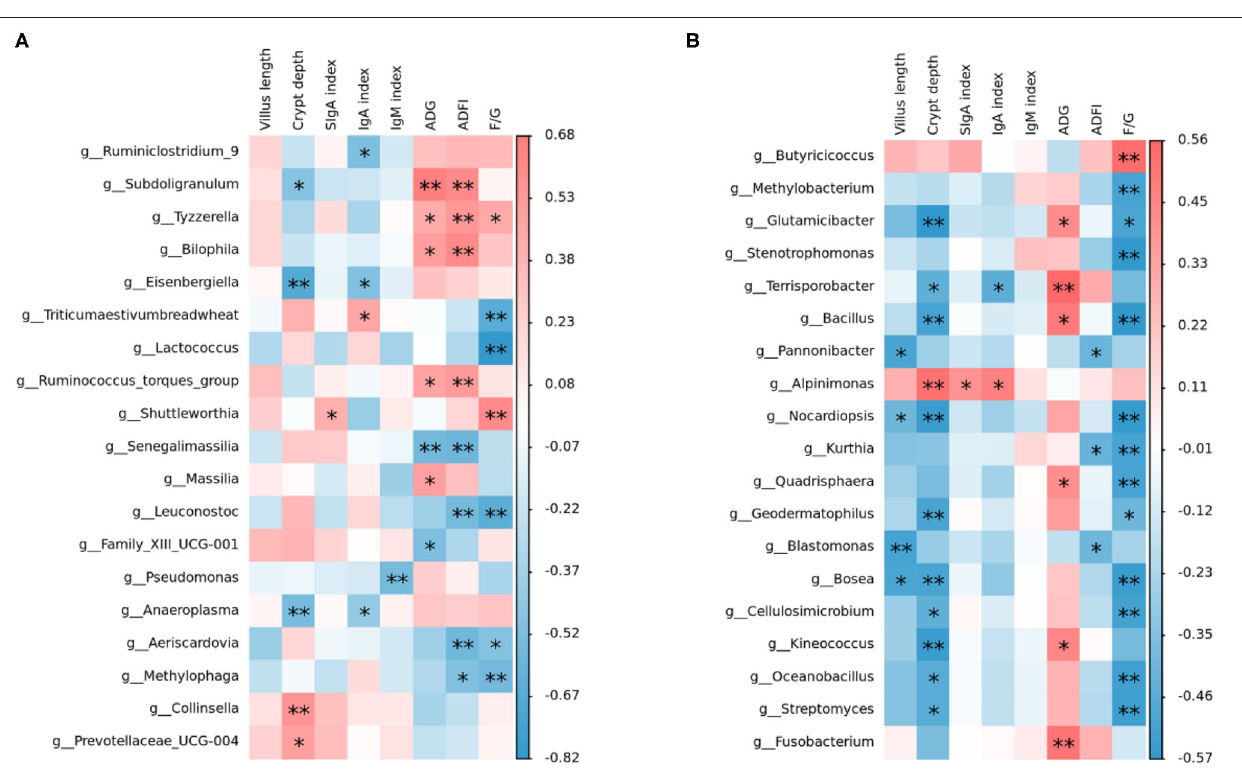
FIGURE 5 | Relationship between intestinal microbiota and indices, including growth performance, serum immunity, sIgA in the ileum, and ileum morphological structure analyzed with a Spearman’s correlation heatmap. (A) Correlation of microbiota with indices on starter phase (1–28 days). (B) Correlation of microbiota with indices on grower phase (29–56 days). The colors range from blue (negative correlation) to red (positive correlation). *represents p < 0.05 and ** represents p <